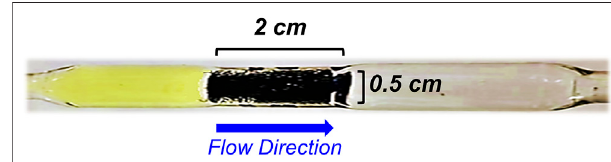
FIGURE7| Photographicimageoftheglass-claddedmonolithicreactor and the color change before and after the monolithic reactor illustrating the